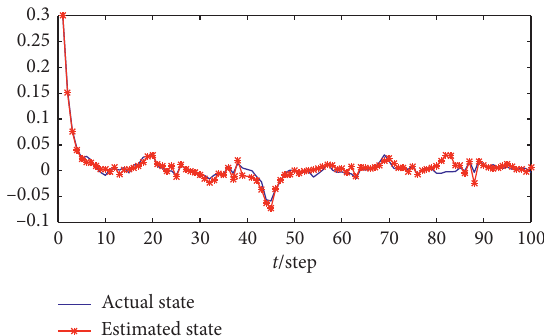
Figure 1: Actual state and its estimated state for the first